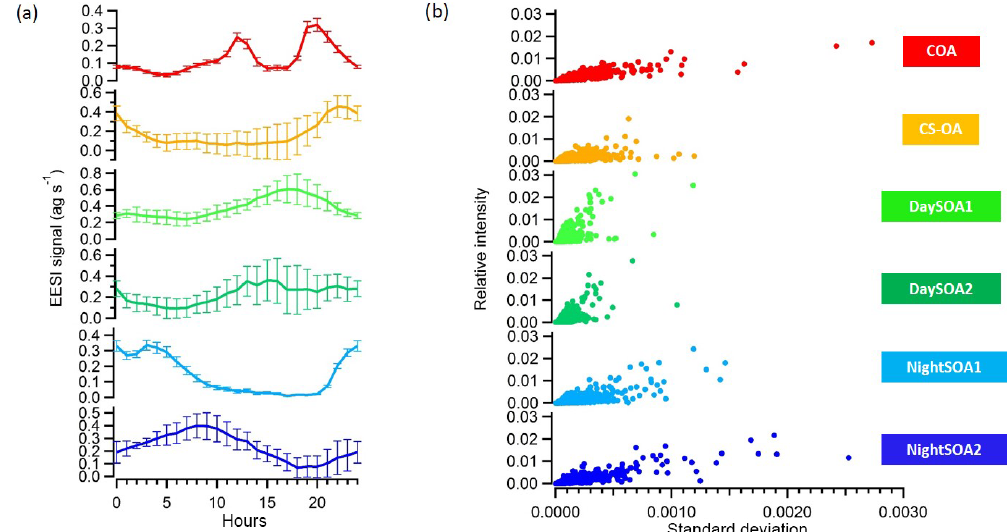
Figure 9. (a) Diurnal variations and (b) scatter plots of the relative intensities and standard deviations among 795 bootstrap runs of the six OA factors identified with PMF from the EESI-TOF-MS